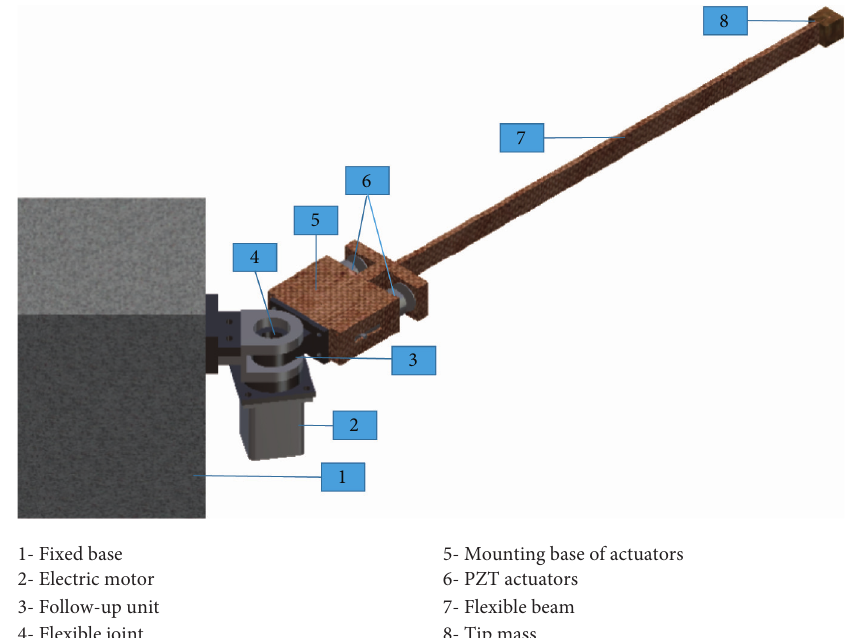
Figure 1: Manipulator with flexible link and flexible